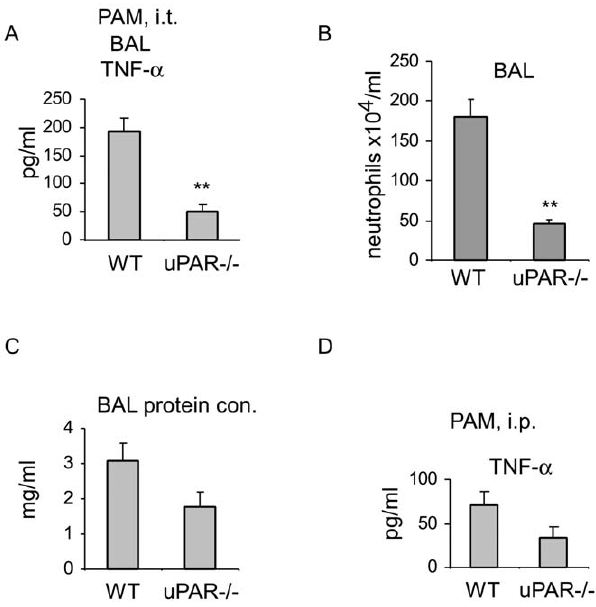
Figure 5. TLR2 induced pulmonary and systemic inflammatory responses are attenuated in uPAR-/- mice. (A–C) WT and uPAR-/- mice were instilled intratracheally (i.t.) with PAM (200 m g/mouse in 50 m l PBS). 24 hours after PAM instillation, the mice were sacrificed and BAL fluids collected. The BAL levels of TNF- a were determined by ELISA (A), neutrophils in the BAL counted (B), and BAL protein concentrations (C) determined. (D) WT and uPAR-/- mice were injected intraperitoneally (i.p.) PAM (200 m g/mouse in 200 m l PBS). 6 hours after PAM injection, blood was withdrawn retro-orbitally and serum prepared. Serum TNF- a levels were determined by ELISA. n=4–5, mean 6 SEM, **p , 0.01 when compared to WT group.